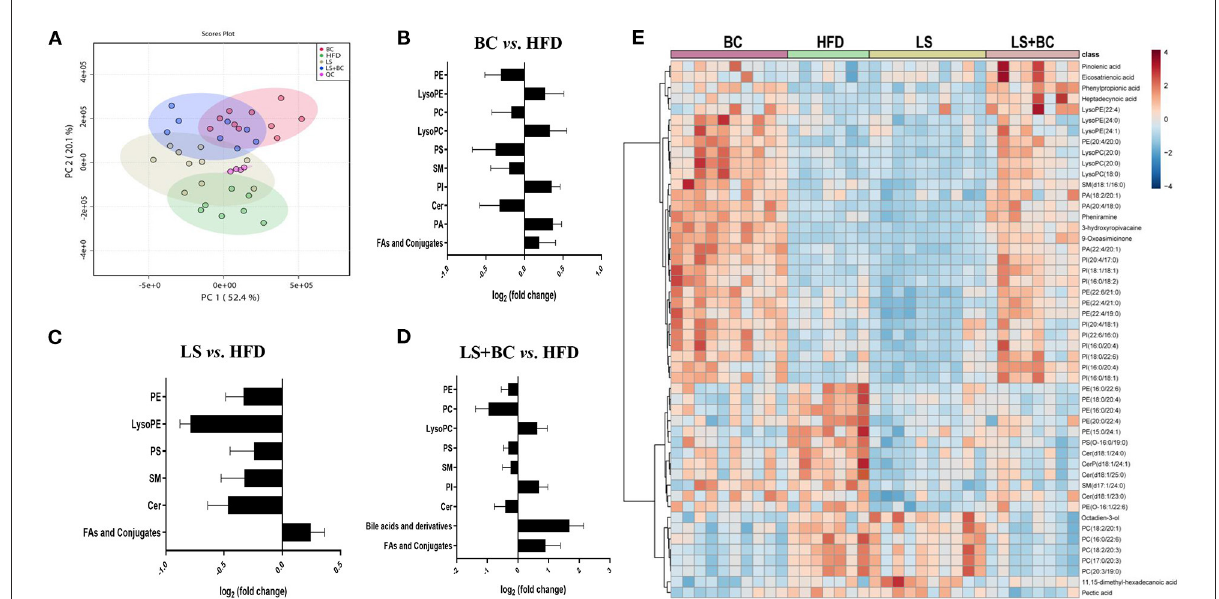
FIGURE5 Effect of BCPs treatment on lipid profiles of serum in HFD-induced obese rats. (A) A two-dimensional principal component analysis (PCA) plot was generated with MetaboAnalyst 4.0 using the peak intensity data, (B–D) total lipids in the serum of BC group vs. HFD group, LS group vs. HFD group and LS + BC group vs. HFD group, respectively. The calculation of fold changes was based on the sum of all intensities of identified lipids of each class. (E) Heat map and hierarchical clustering of 50 identified differential lipids in the four